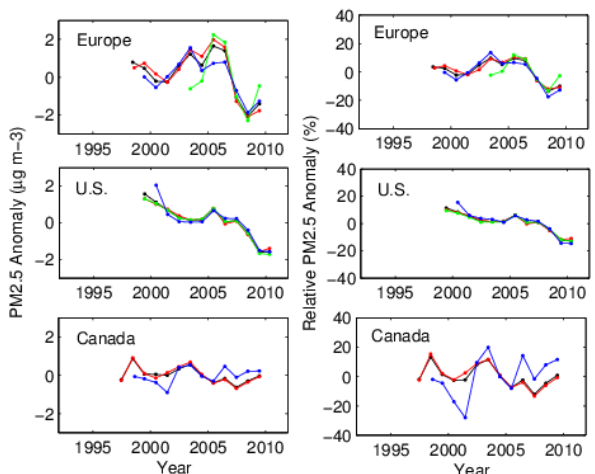
Figure 4. Annual anomalies (left) of PM10 and their relative anomalies (normalized by multi-year averaged PM10 value from each site) (right). Black lines represent averages over total sites, red lines represent urban averages, green lines represent suburban averages, and blue lines represent rural averages. Multi- year regional averages of PM10 can be found in Table 1.